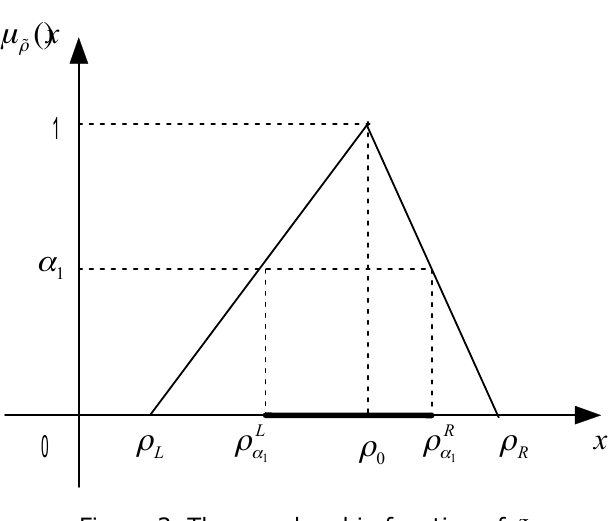
Figure 3. The membership function of